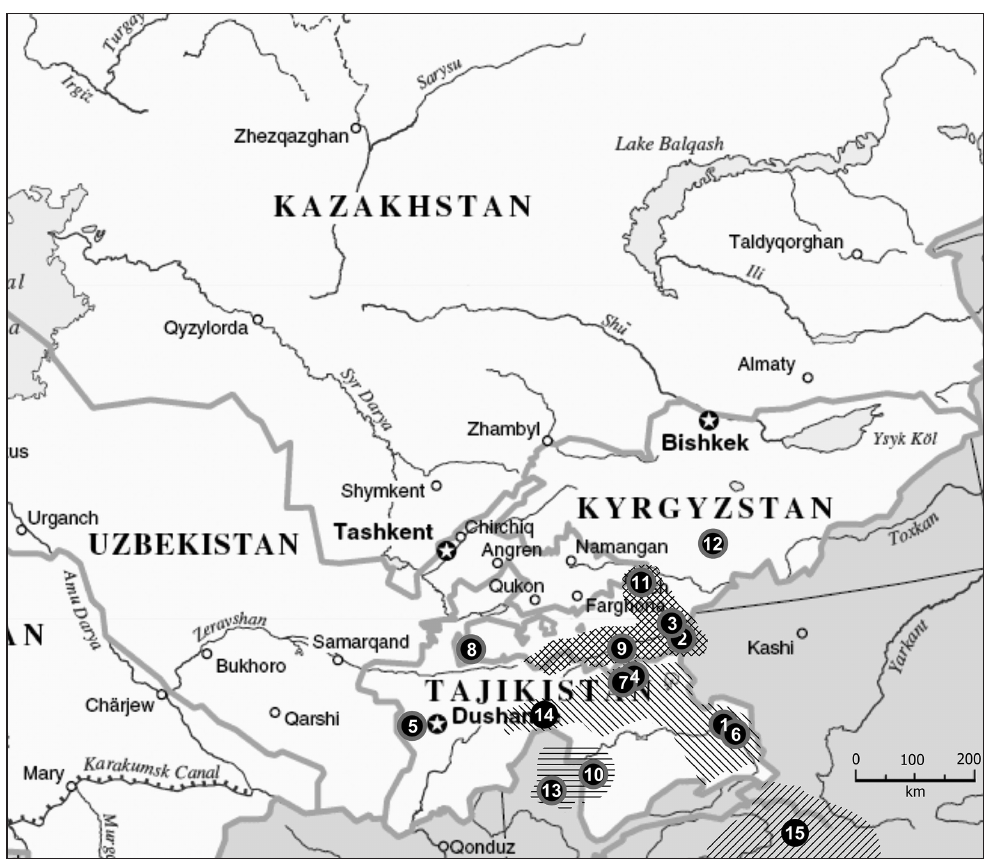
Figure 5. Distribution map of Koramius charltonius (Gray, 1853) in Central Asia. Black circles – type lo - calities of described subspecies with no DNA sampled by us (mined from GenBank); black circles with grey ovals – type localities with sampled specimens (paratypes or topotypes). For numbers see Table